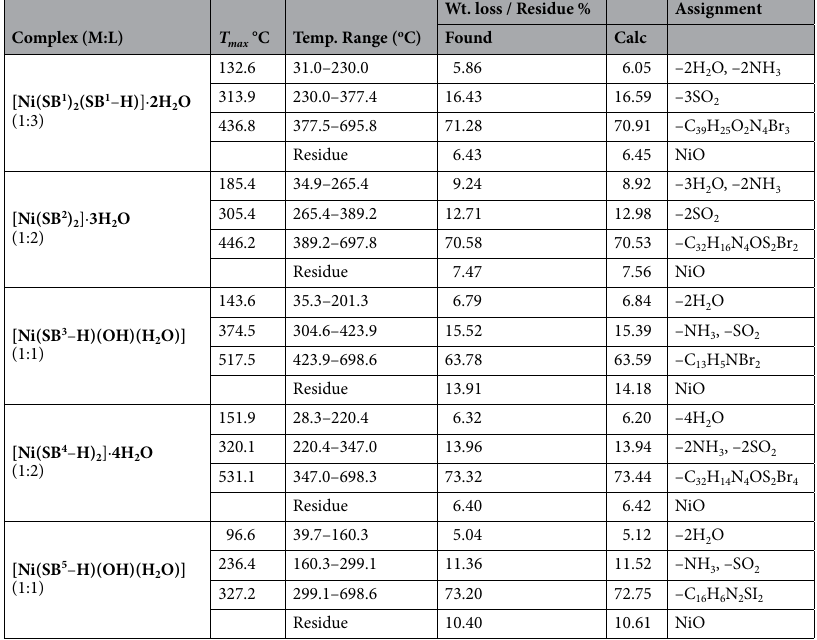
Table 2. Thermogravimetric decomposition steps of Ni(II) complexes derived from SB 1 –SB 5 .